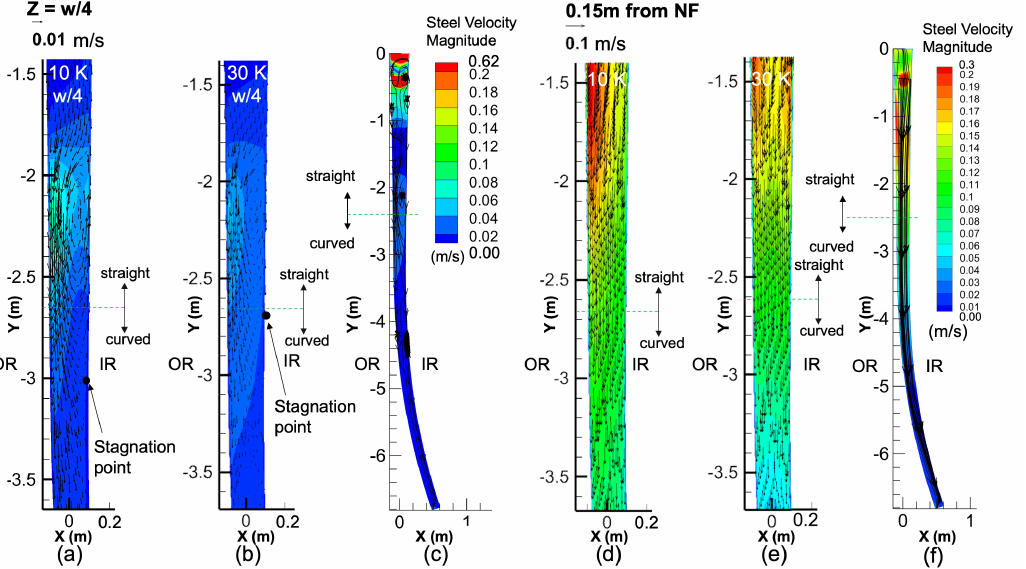
Figure 13. Steel velocity distribution—side view: on width/4 plane: ( a ) 10 K superheat close-up view, ( b ) 30 K superheat close-up view, and ( c ) 30 K superheat full view; on plane 0.15 m away from NF: ( d ) 10 K superheat close-up view, ( e ) 30 K superheat close-up view, and ( f ) 30 K superheat full